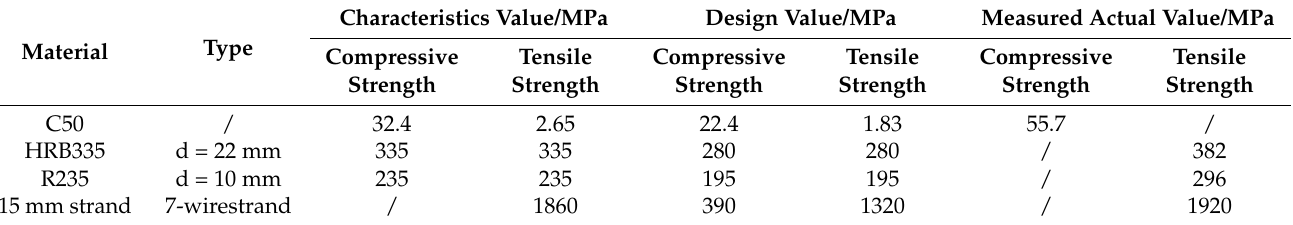
Table 1. Material parameters.